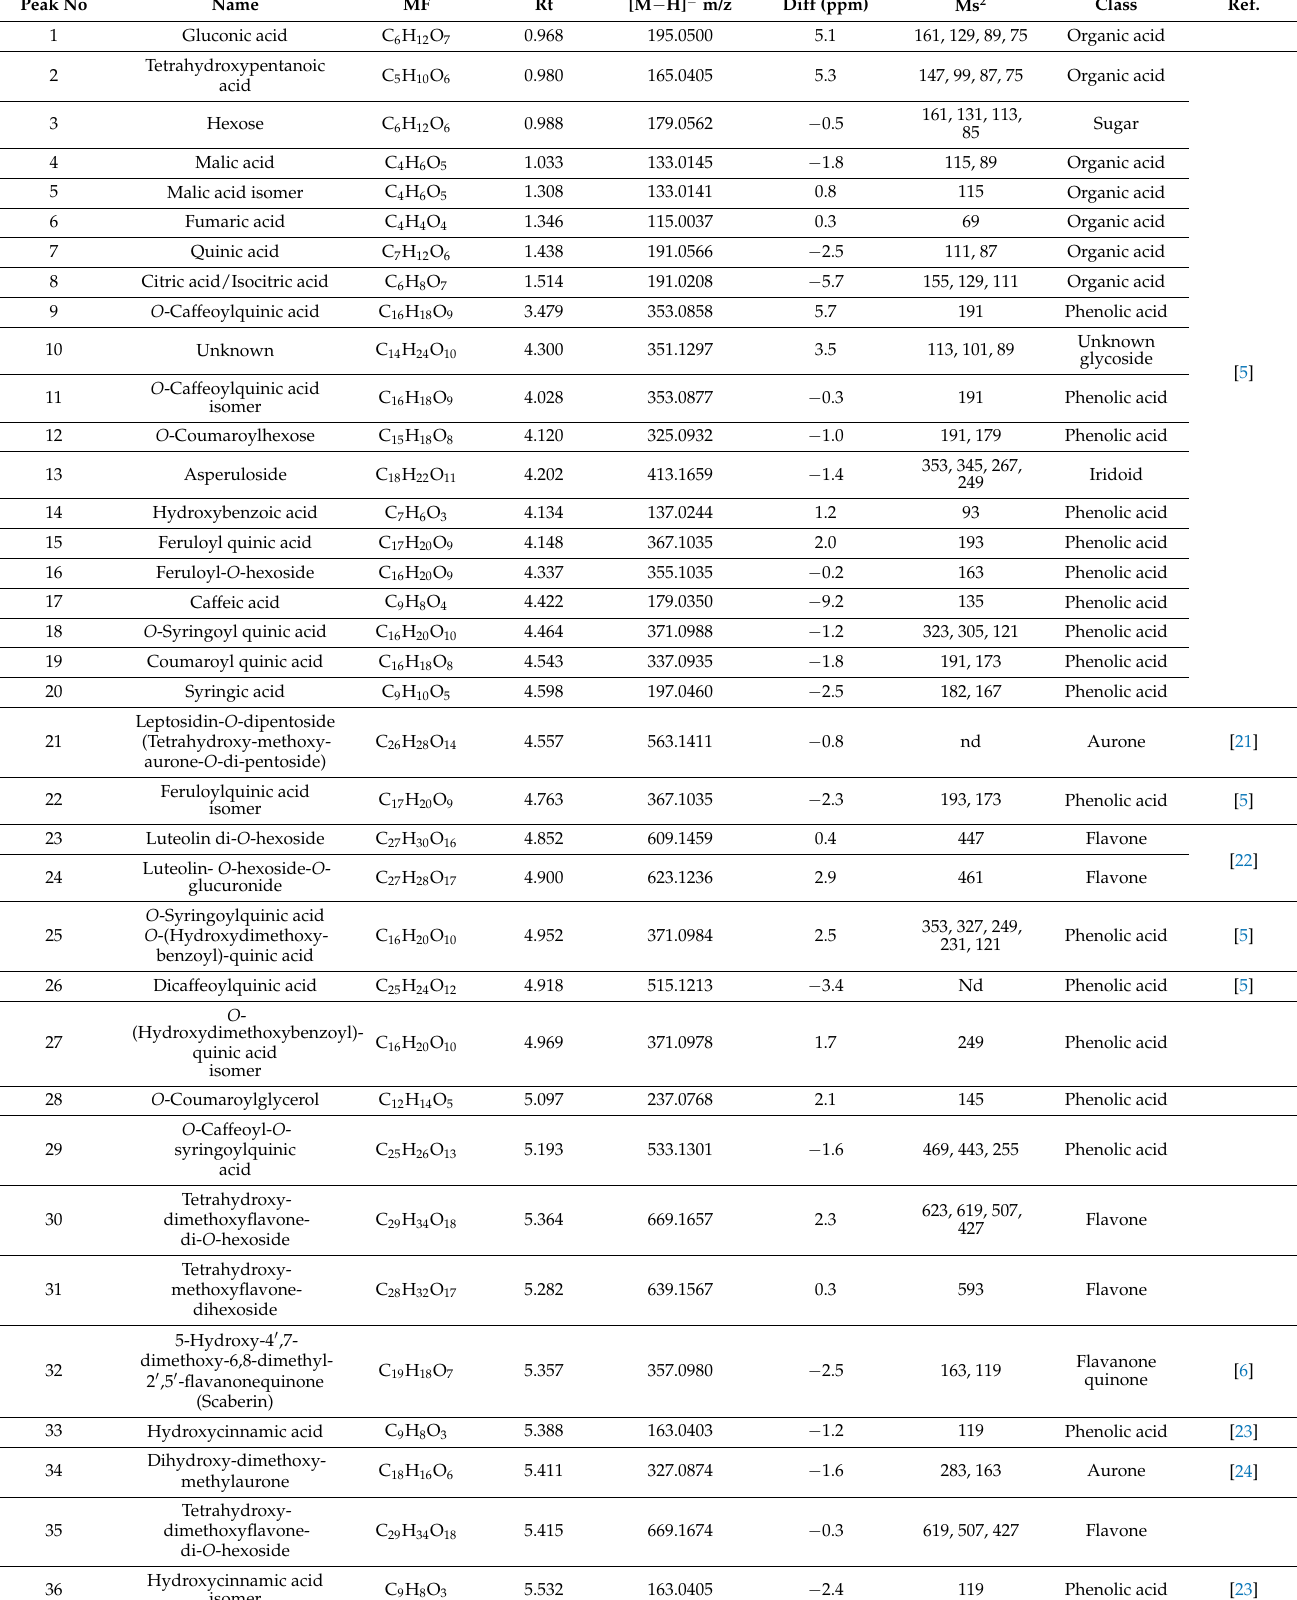
Table 1. Metabolites profiling of CLEE via UPLC-QTOF–MS/MS analysis in negative ion